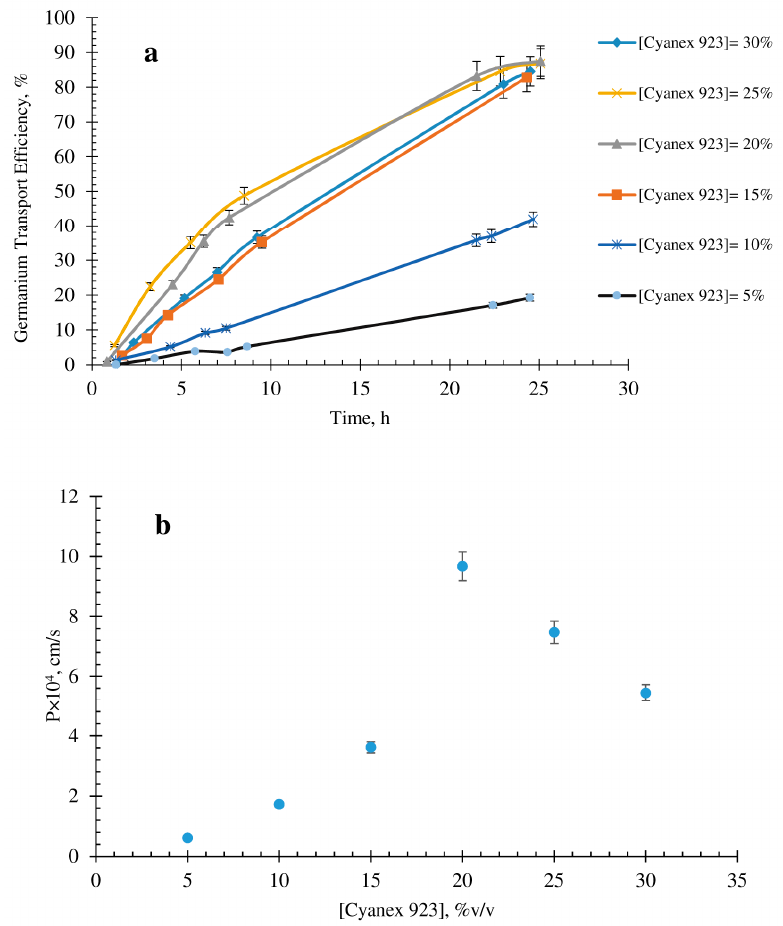
Figure 4. E ff ect of the carrier concentration on ( a ) transport and ( b ) permeability coe ffi cient Figure 4. Effect of the carrier concentration on ( a ) transport and ( b ) permeability coefficient of of germanium on the FSSLM system ([Oxalic acid] = 0.075 mol / L, temperature of 22 ◦ C, and germanium on the FSSLM system ([Oxalic acid] = 0.075 mol/L, temperature of 22 °C, and [NaOH] = [NaOH] = 0.1 mol / 0.1 mol/L).